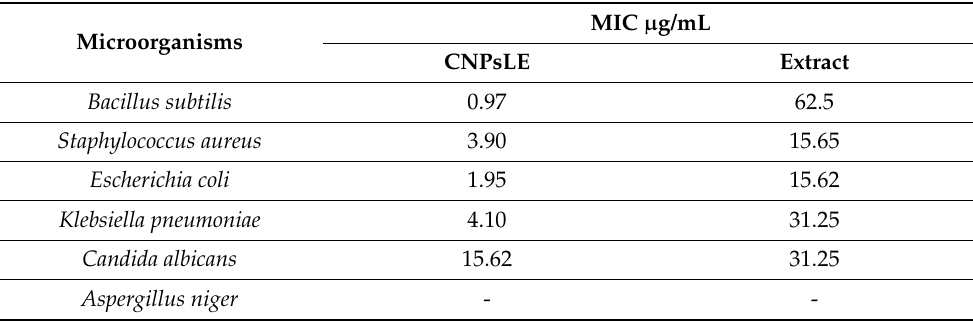
Table 2. Minimum inhibitory concentration (MIC) of Artemisia judaica extract and chitosan nanoparti- cles loaded extract (CNPsLE) towards multiple pathogenic bacterial and fungal species. MIC µ g/mL Microorganisms CNPsLE Extract Bacillus subtilis 0.97 62.5 Staphylococcus aureus 3.90 15.65 Escherichia coli 1.95 Klebsiella pneumoniae Candida albicans Aspergillus